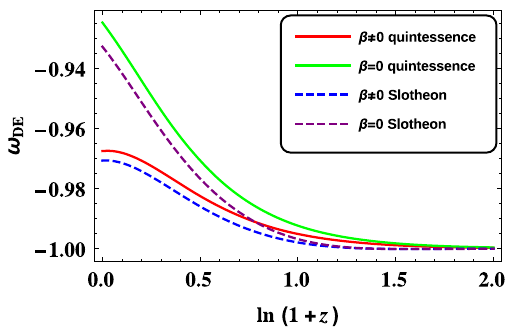
Fig. 4 Variations of dark energy equation of state parameters with redshift for quintessence dark energy (solid lines) and Slotheon field dark energy (dashed lines). Comparison between these two models of dark energy are shown in the presence of DM–DE interactions as